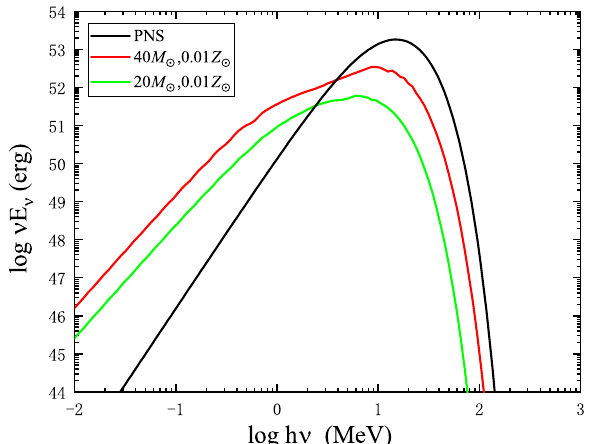
Figure 5. Time-integrated electron neutrino spectra of a PNS and NDAFs in the center of a collapsar. The black curve corresponds to a PNS, and the green and red lines correspond to NDAFs in the center of progenitor stars with ( M pro / M (cid:12) , Z / Z (cid:12) ) = (20, 0.01) and (40, 0.01), respectively. (adapted with permission from Ref.